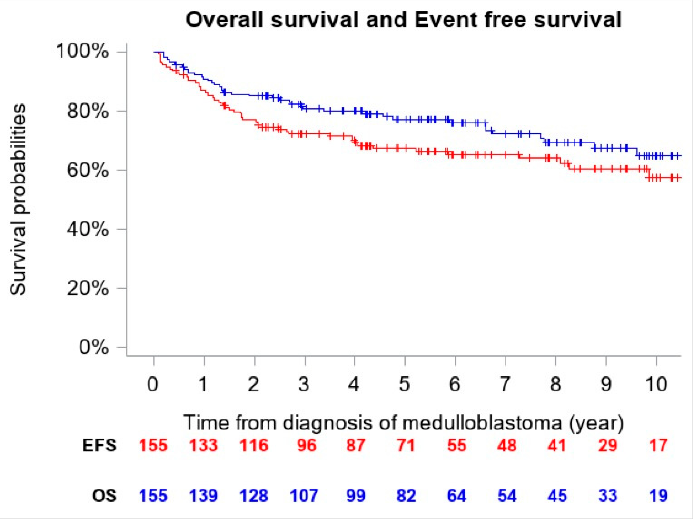
Figure 1. Overall Survival (OS) and Event Free Survival (EFS) of the entire cohort ( n = 155). When comparing outcomes of patients according to molecular subgroups, WNT tumors had the best 5-year EFS and OS, followed by Group 4 and SHH MB, then Group 3. Of note, OS and EFS were not adjusted for differences in upfront treatment (RT-based regimen vs. CT only) (Figure